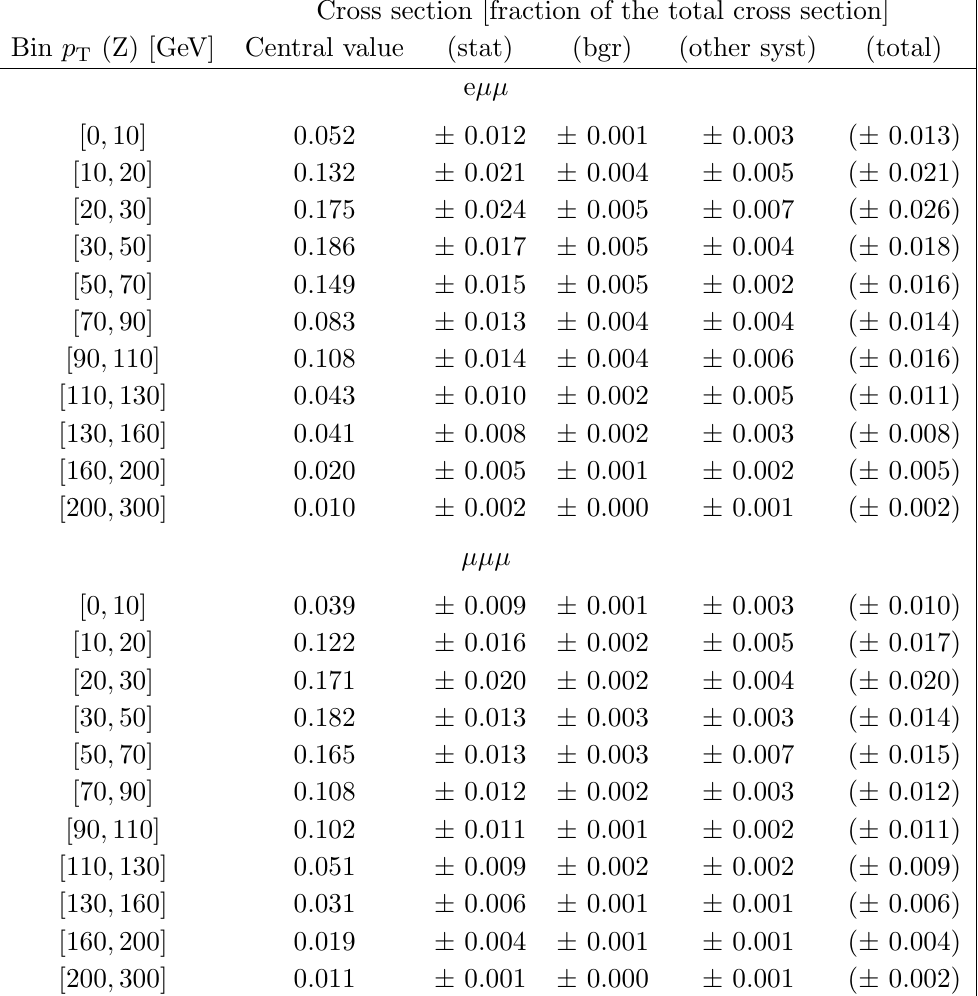
Table 8 . Di(cid:11)erential cross section in bins of p T (Z). Values are expressed as a fraction of the total cross section. The e (cid:22)(cid:22) and (cid:22)(cid:22)(cid:22) (cid:12)nal states are shown.